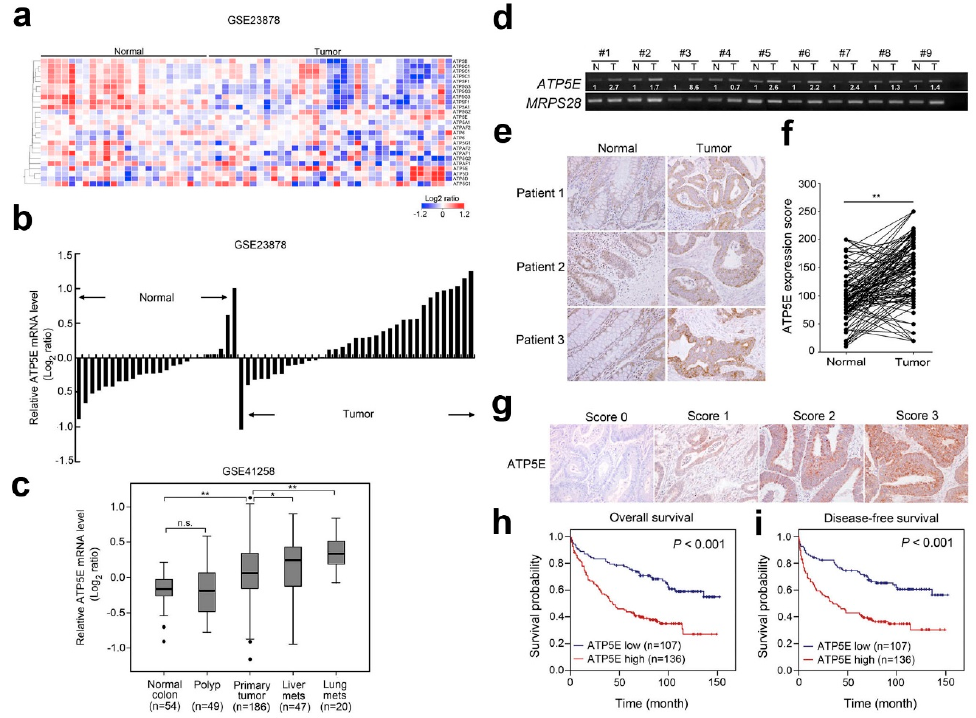
Figure 1. Overexpression of the ATP synthase epsilon subunit (ATP5E) in colorectal cancer (CRC) is associated with distal metastasis and a poor prognosis. ( a ) Microarray expression patterns of genes encode for ATP synthase in the GSE23878 dataset containing 36 CRC tissues and 24 non-cancerous colorectal tissues. ( b ) Relative expression of the ATP5E gene in the GSE23878 dataset ranked from lowest to highest. ( c ) Microarray expression patterns of the ATP5E gene were compared among 54 normal colon tissues, 49 polyp tissues, 186 primary tumors, 20 lung metastatic tumors, and 47 liver metastatic tumors in the GSE41258 dataset. ( d ) RT-PCR analysis of ATP5E levels in normal colon tissues (N) and tumor tissues (T) derived from nine patients. Data were normalized to the corresponding MRPS28 level. ( e ) Representative IHC staining of ATP5E levels in normal colon and primary CRC tissues. ( f ) Distribution of immunoreactivity scores in normal colon and primary CRC tissues ( n = 60). The scores were determined by the staining intensity x percentage of positive cells. ( g ) Representative scores for ATP5E IHC staining in CRC patients. ( h ) Kaplan-Meier plot of overall survival for 243 CRC patients, stratified by the ATP5E level. ( i ) Kaplan-Meier plot of disease-free survival for 243 CRC patients, stratified by the ATP5E